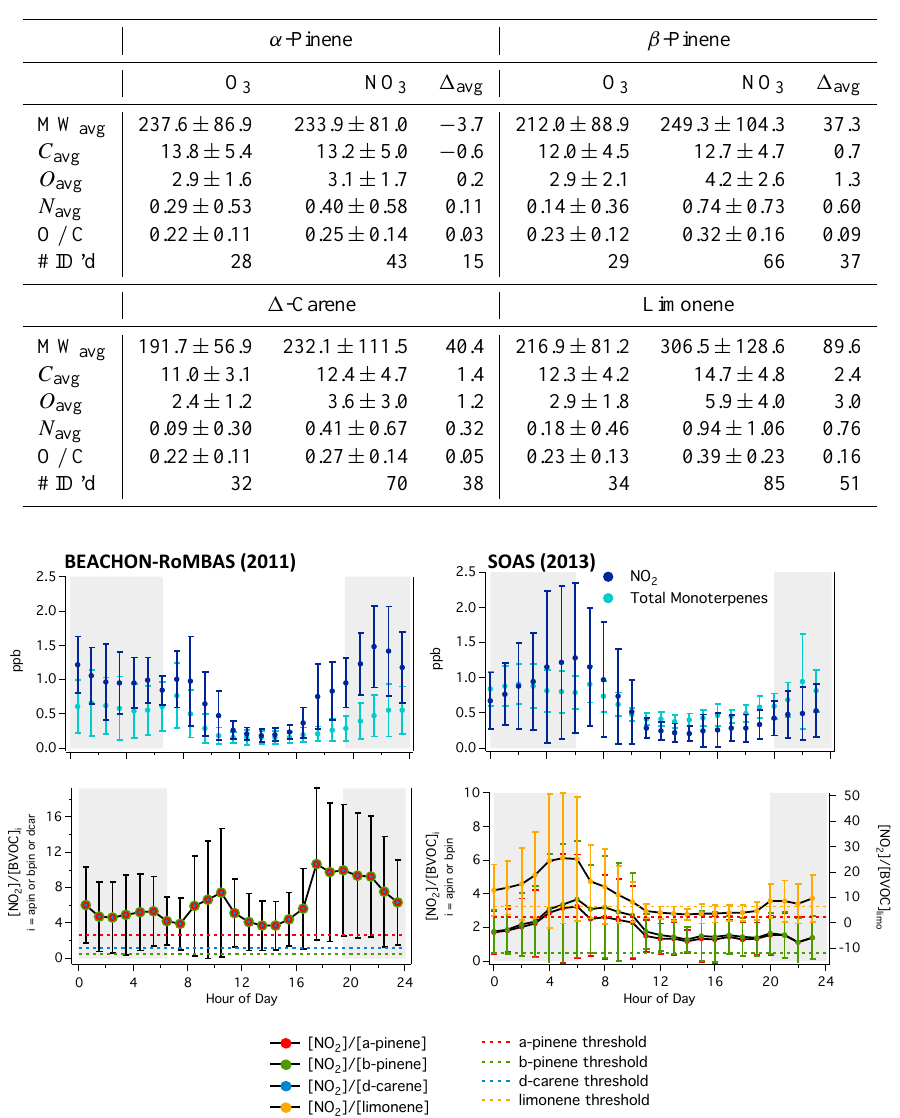
Figure 8. Diurnal average NO 2 and monoterpene concentrations (top panels) are shown for two field campaigns: BEACHON-RoMBAS 2011 (left panels) and SOAS 2013 (right panels) which both occurred at heavily biogenically influenced sites. The bottom panels show the diurnally averaged [NO 2 ] / [BVOC] ratios for the speciated monoterpenes used in this study. The speciated monoterpenes for BEACHON- RoMBAS are estimated as being 1 : 1 : 1 α -pinene : β -pinene : (cid:49) 3 -carene; hence, each BVOC concentration is assumed to be a third of total measured [BVOC]. Shaded regions indicate nighttime